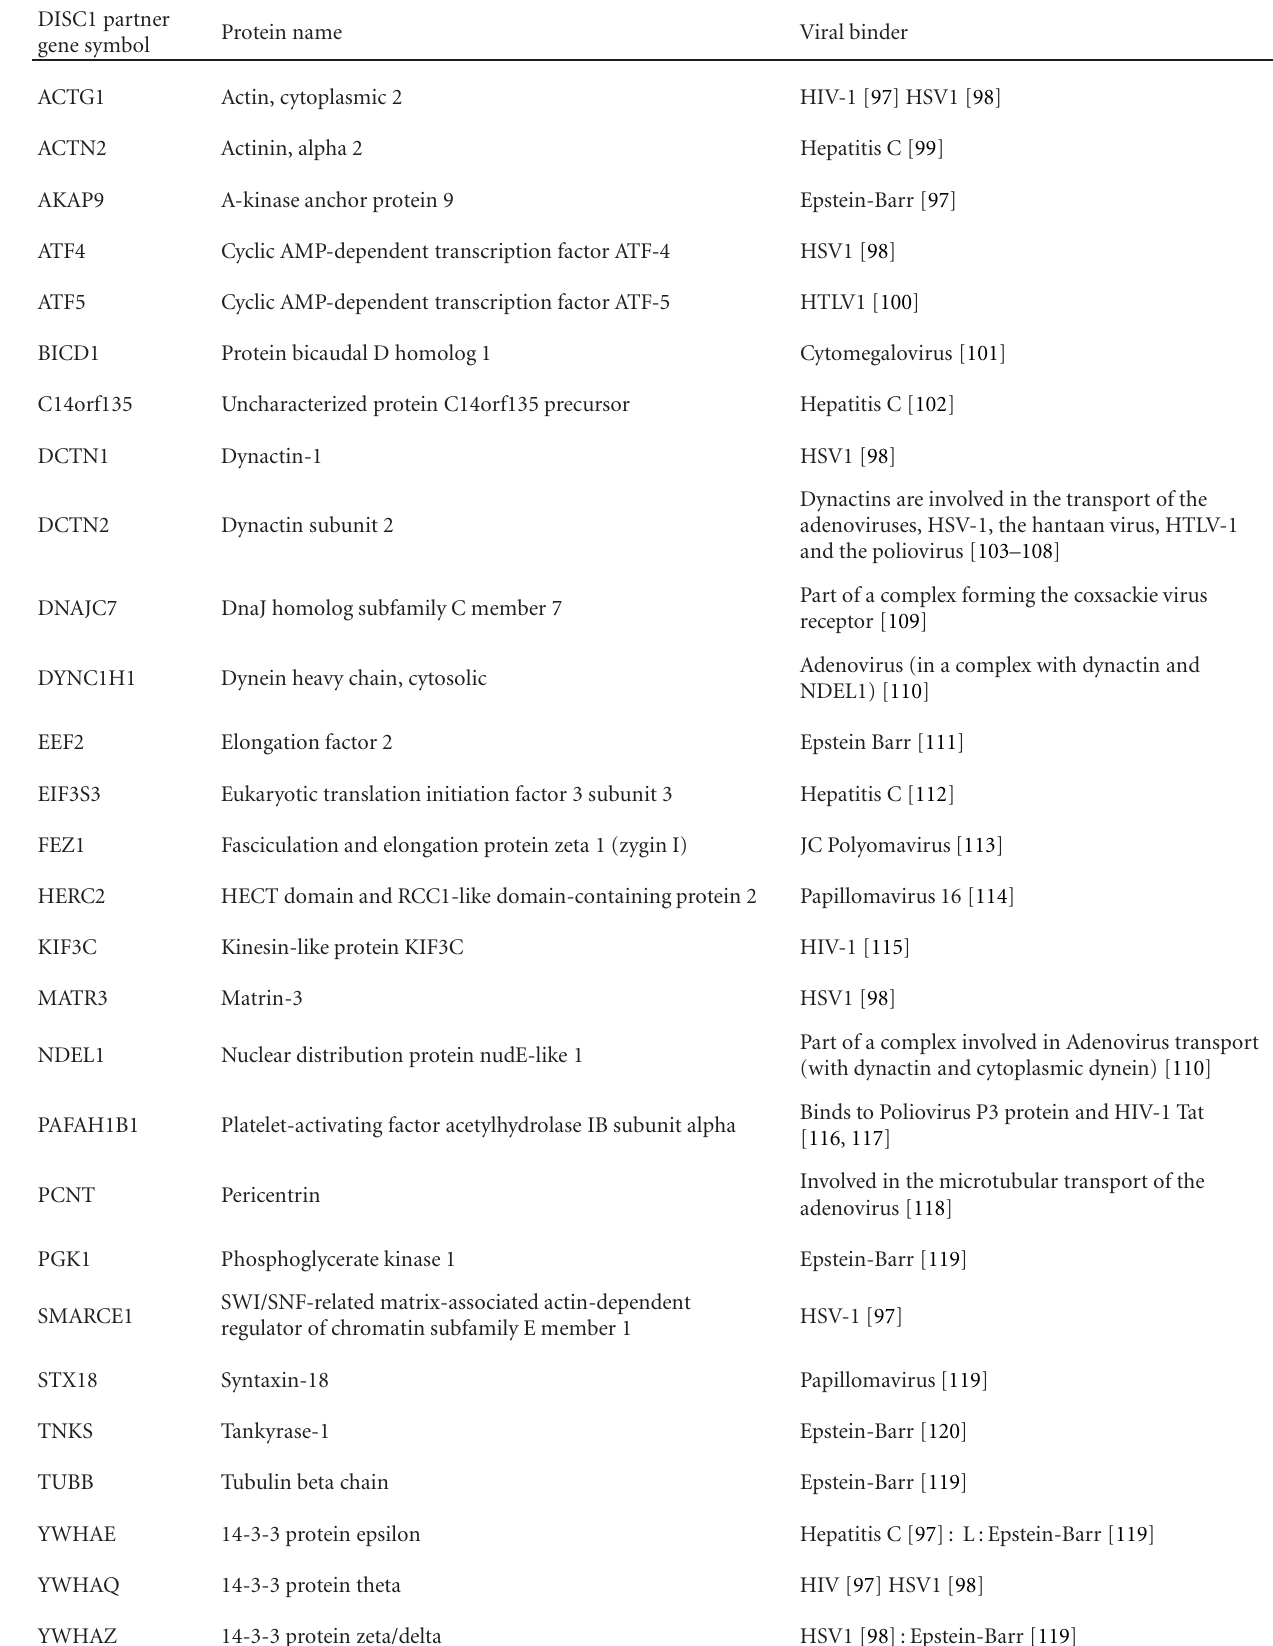
Table 4: Viruses reported to bind to DISC1 interactome